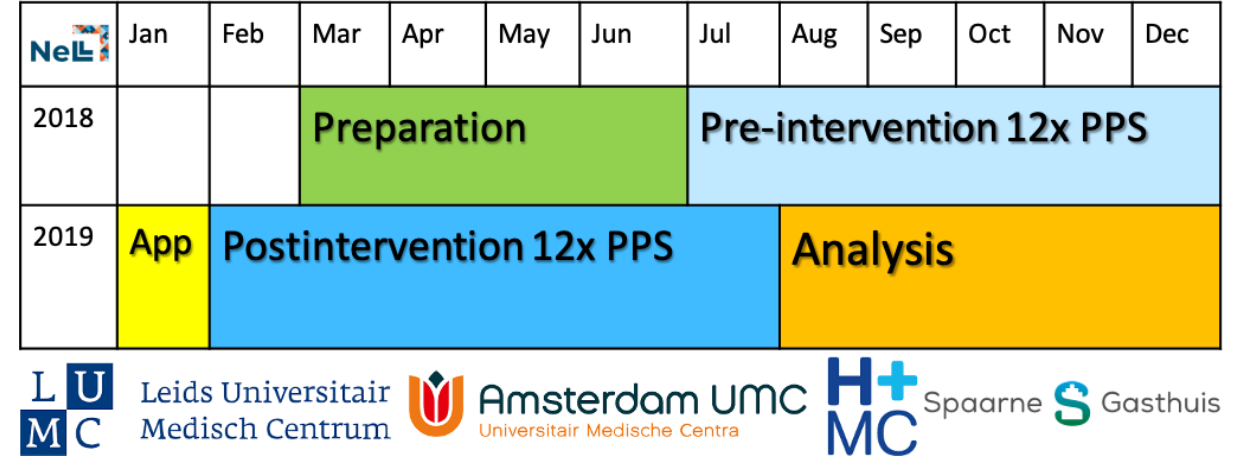
Figure 2. Interrupted time-series analysis design with point-prevalence surveys